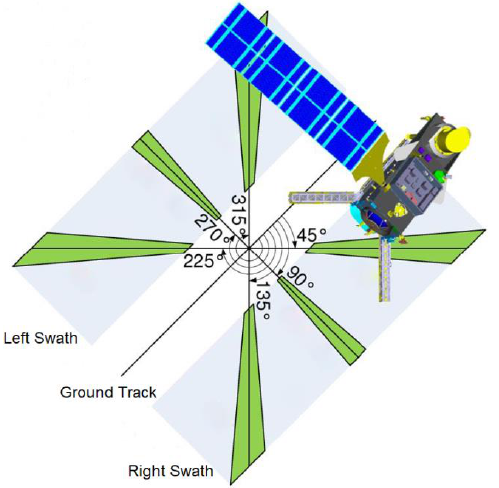
Figure 2. SCA beam geometry. Figure 2. SCA beam